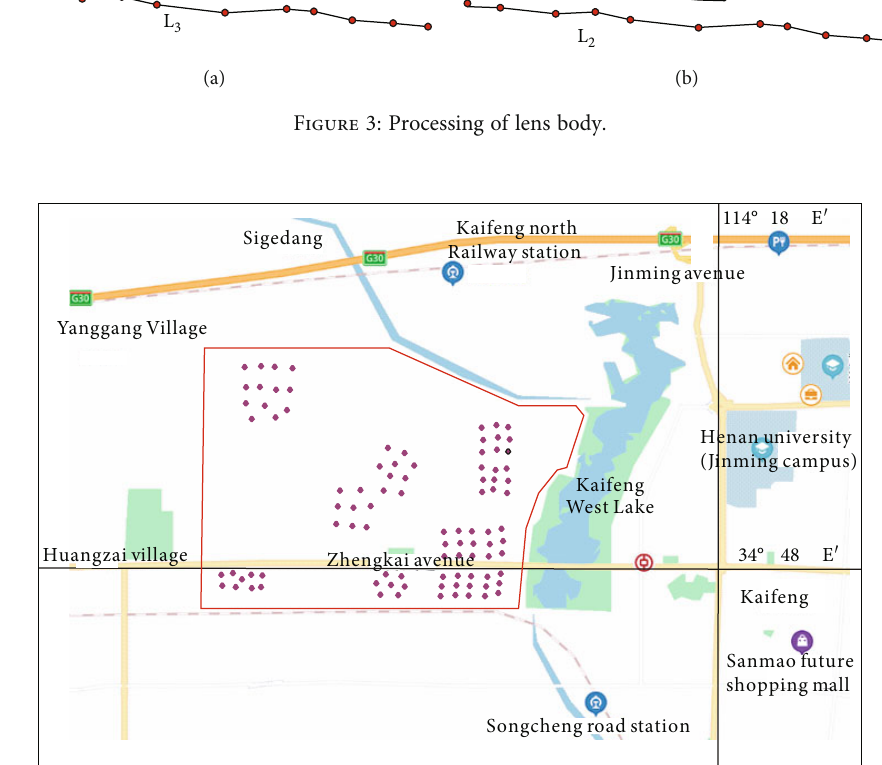
Figure 4: Geological research area in Kaifeng City (modi fi ed by Google